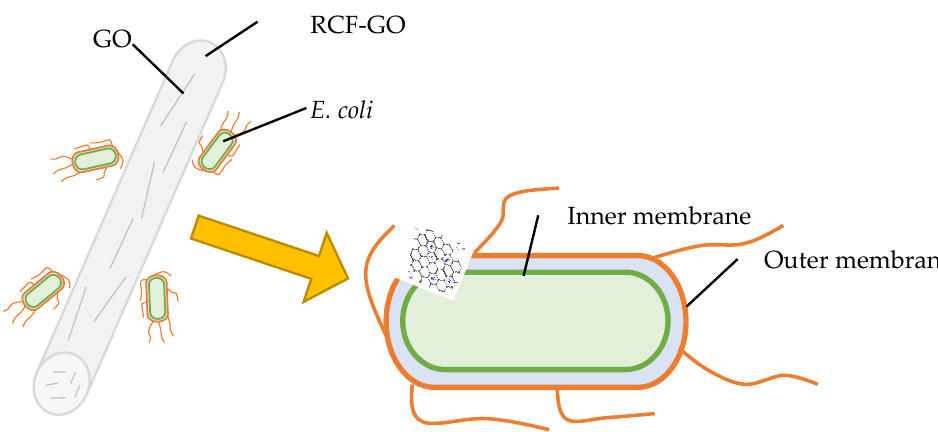
Figure 11. Schematic of the “nano-blade” effect of GO towards a Gram-negative bacterial cell ( E. coli ).